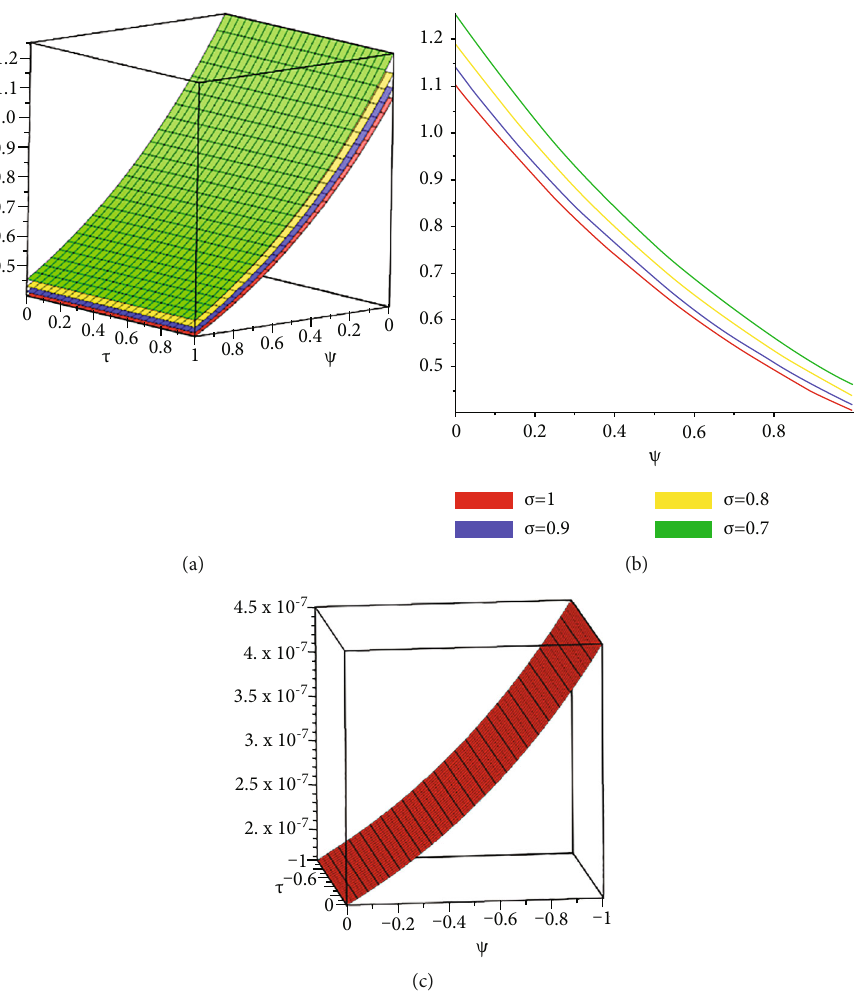
Figure 3: Example 2. (a) Analytical solution at various fractional orders of σ (b) ϕ = 0 : 5 and (c)